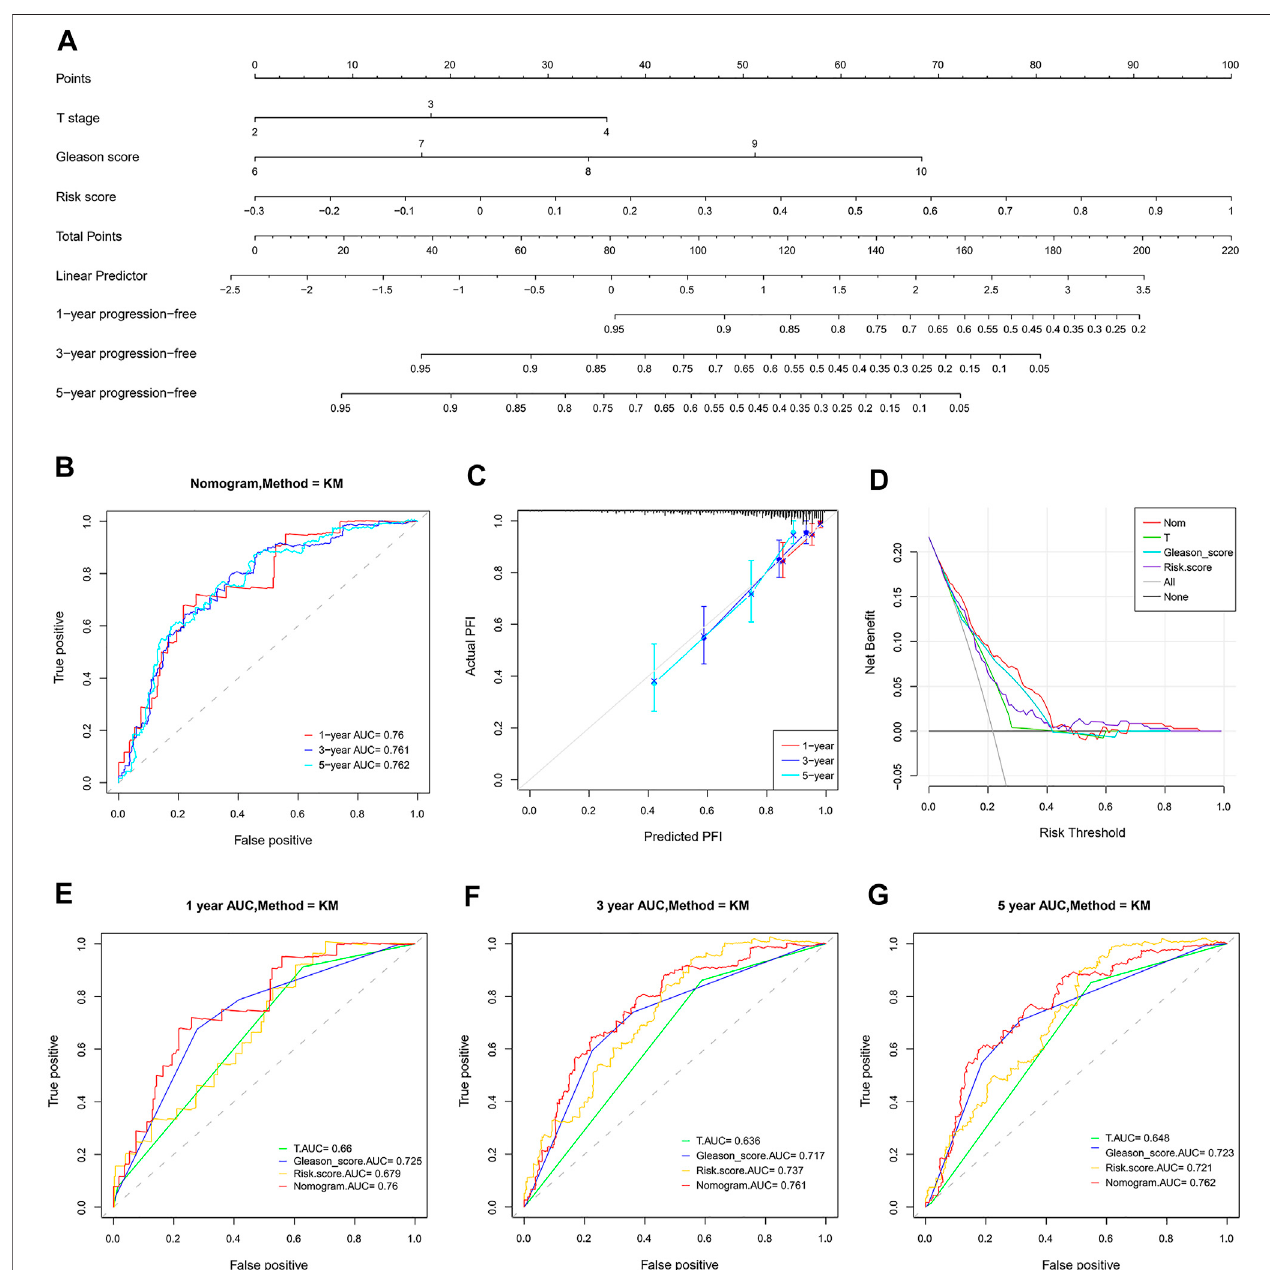
FIGURE 11 | Establishment and validation of a combined nomogram. (A) The nomogram predicts PFI based on risk score, T stage, and Gleason score. (B,E – G) The prognostic value of the nomogram is better than that of any single factor con fi rmed by the ROC analysis. (C) Predictive capacity of the nomogram assessed by the calibration plots. (D) Predictive capacity of the nomogram assessed by